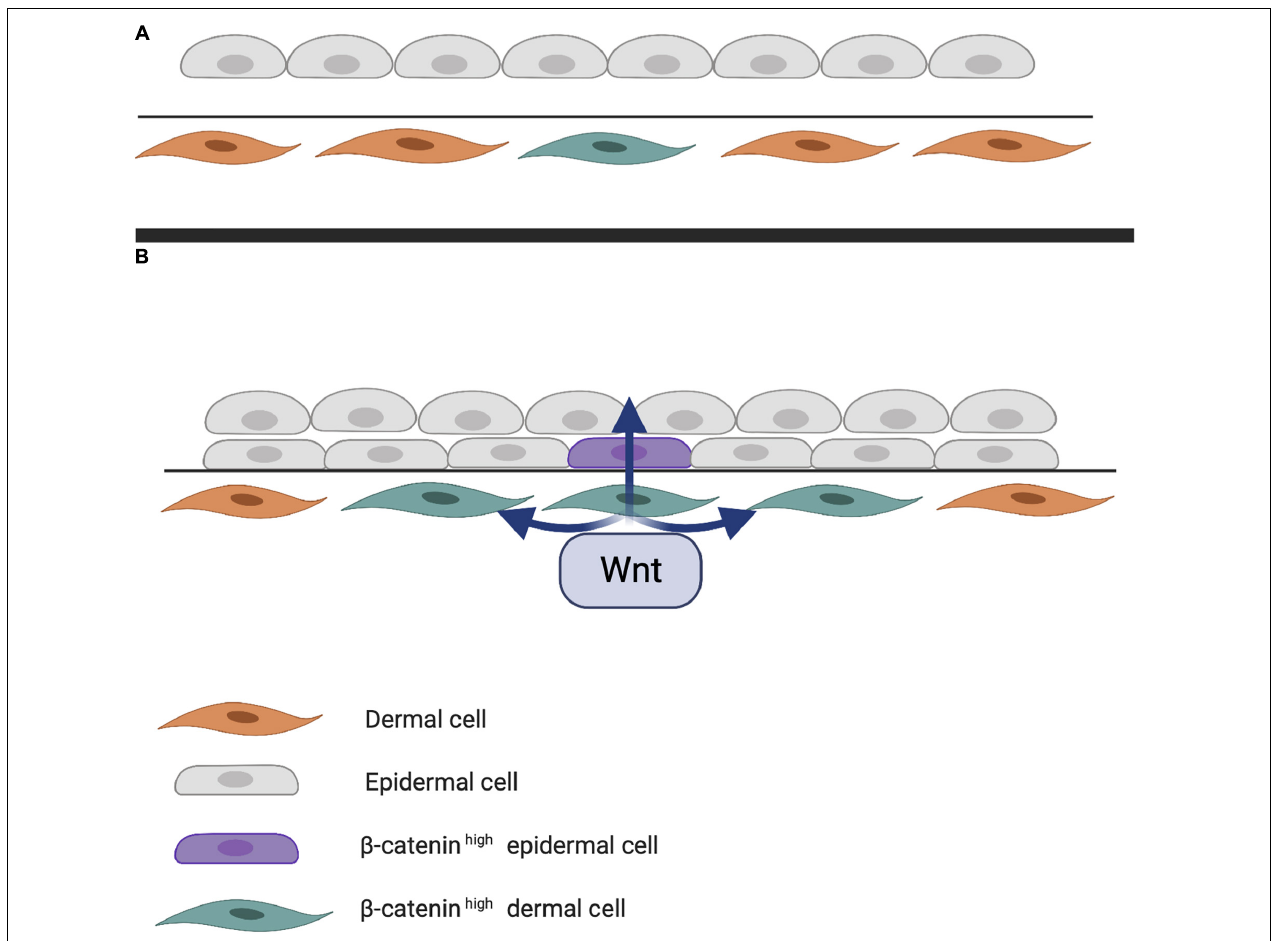
FIGURE 1 | (A) First step of hair follicle (HF) induction. Through an unknown trigger, intracellular β -catenin accumulates in the dermis, activating various transcription factors in the nucleus. (B) Next step of HF induction. Intracellular dermal β -catenin induces expression of WNT ligands that activate neighboring cells and eventually those in the epithelial layer. Epithelial WNT activation results in a high concentration of intracellular β -catenin in the